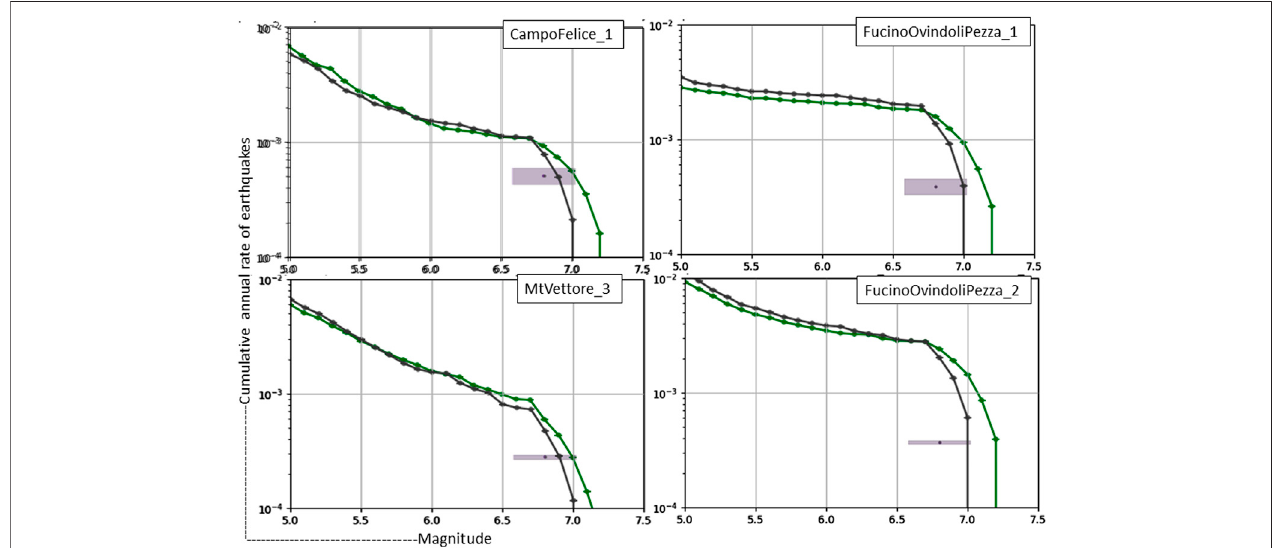
FIGURE6| Comparison ofSHERIFS ’ ssyntheticearthquakeratesresultingfromthemodelconsidering10or15 kmthickseismogeniclayer(blackand greenlines respectively) and MF-section- speci fi c paleoseismological rates (violet boxes). The violet boxes are centered at M (cid:1) 6.8 and have ± 0.2 uncertainty width (see text for method).